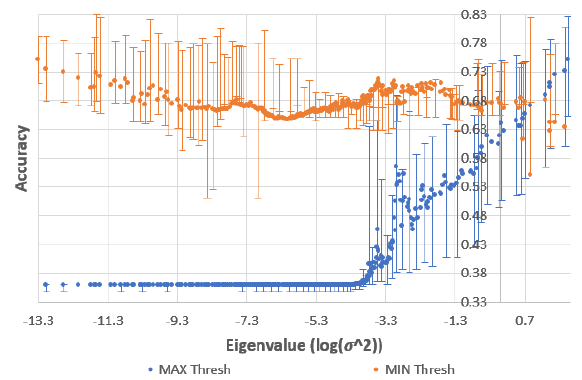
Figure 2. Accuracy measurements in relation to dif- ferent eigenvalue thresholds